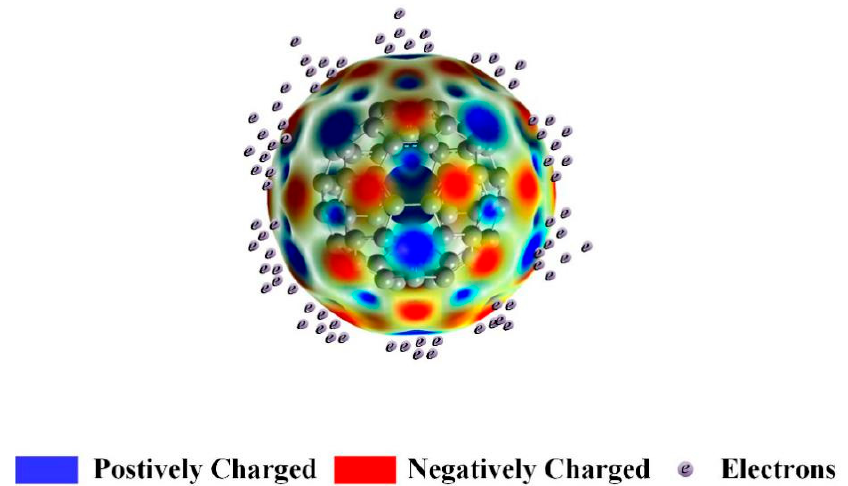
Figure 13. The calculation of electron density distribution on fullerene and the sketch figure for attracted electrons.